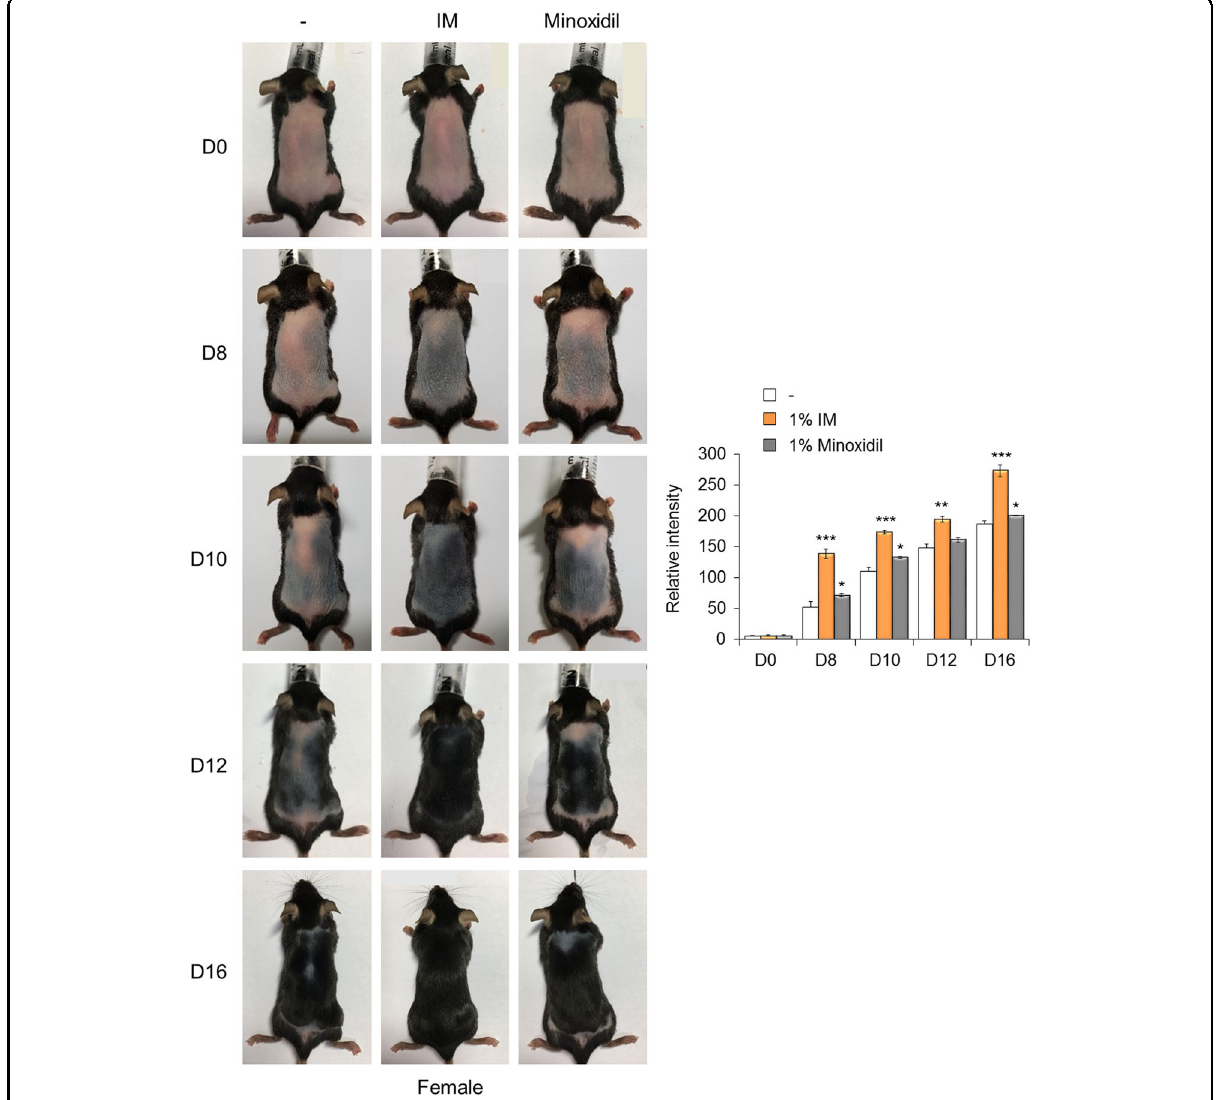
Fig. 3 IM promotes hair regrowth in mice. C57BL/6 mice in the telogen phase (7 weeks old) were depilated. Placebo control ( − ), 1% IM, or 1% minoxidil was topically applied daily to the dorsal skin. Representative photos of mice showing skin color darkness and hair regrowth on days 8, 10, 12, and 16 (left). The level of pigmentation was quanti fi ed by the intensity of the darkness of the back skin in the same area (right). * p < 0.05; ** p < 0.01; *** p < 0.001 (Student ’ s t